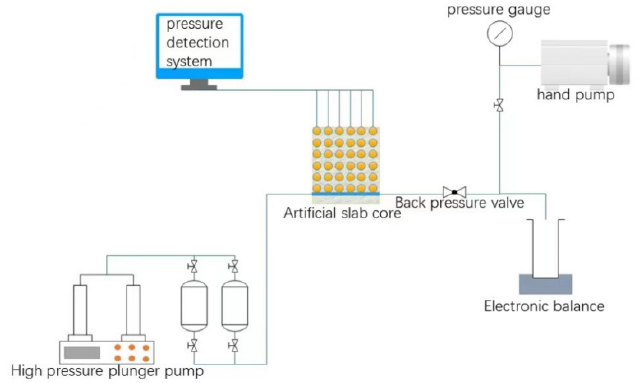
Figure 3. Schematic diagram of flat core experiment.